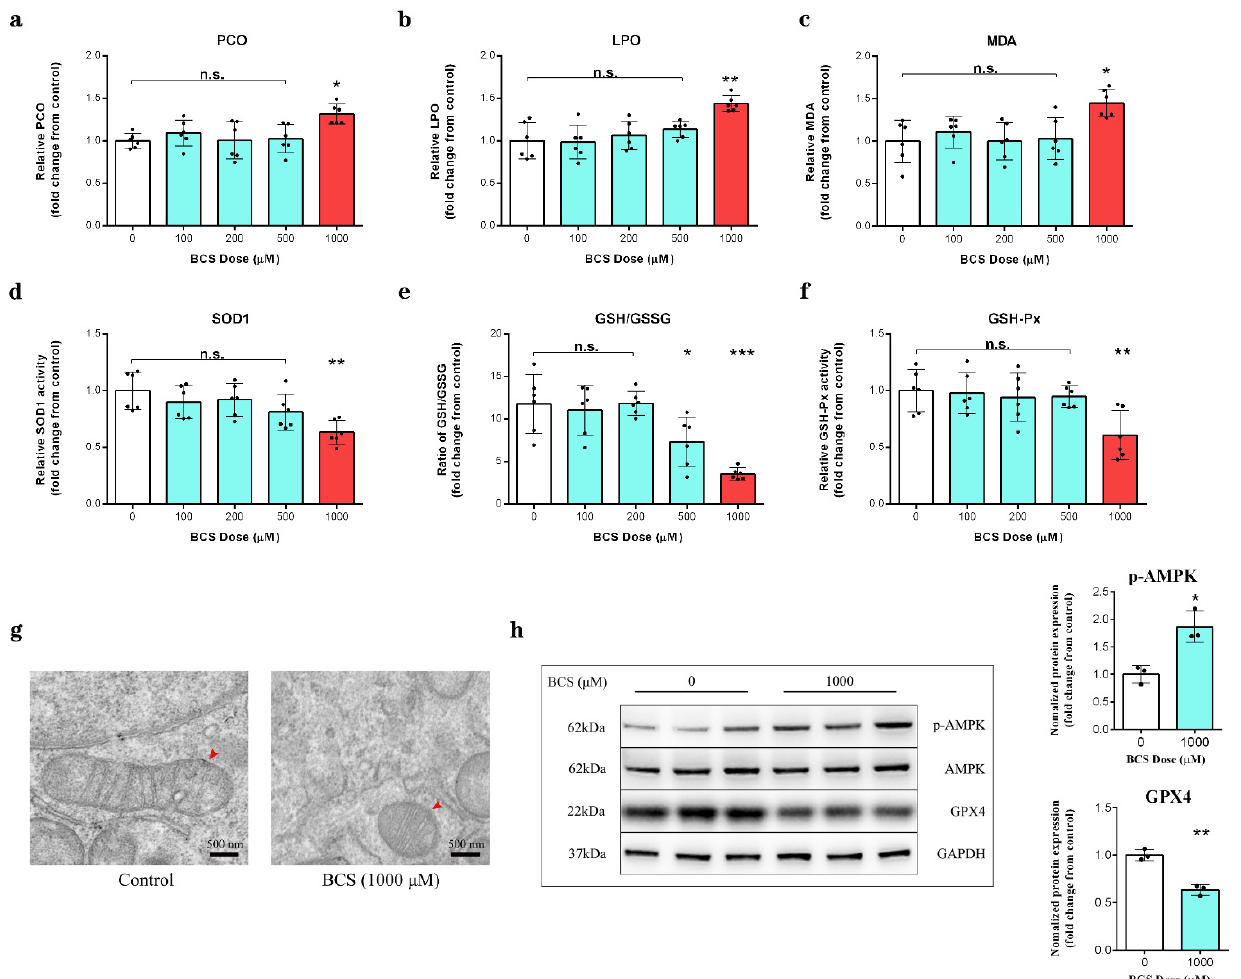
Figure 3. ( a – c ) Measurement of protein carbonylation, LPO, and MDA contents in DPCs after 72 h of treatment with BCS (1000 μ M) ( n = 6/group). n.s. no significance; * p < 0.05; ** p < 0.01. ( d )